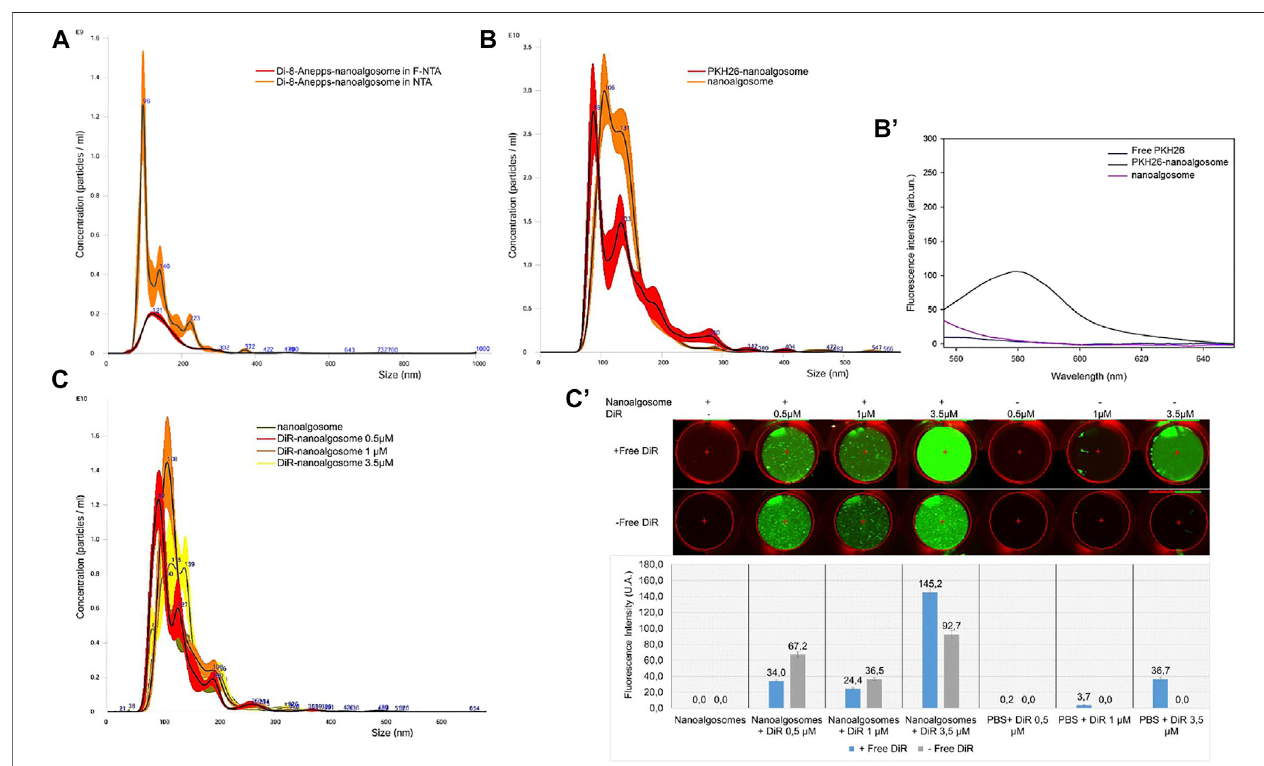
FIGURE 2 | Fluorescent staining of nanoalgosomes with three different dyes (A) Fluorescent-NTA (F-NTA) and standard (scattering mode) NTA to determine the size distribution and concentration of nanoalgosomes stained with Di-8-ANEPPS. This comparative analysis gives the concentration of fl uorescent nanoparticles, excluding non-vesicle contaminants. (B) Size distributions and concentrations by NTA of PKH26-labelled nanoalgosomes and unstained nanoalgosomes, showing a largely overlapping distribution. (B ’ ) Fluorescent emission spectra of PKH26-labelled nanoalgosomes compared to PKH26 free dyeandunstainednanoalgosomes. (C) SizedistributionandconcentrationanalysesbyNTAofnanoalgosomesstainedwithDiRatdifferentconcentrationsshowno variation compared to unstained nanoalgosomes after the free dye removal. (C ’ ) Infrared fl uorescent emission imaging and intensities ( λ 800nm ) obtained using an Odyssey IR scanner of DiR-labelled nanoalgosomes and free dye at different concentrations before and after free dye removal.